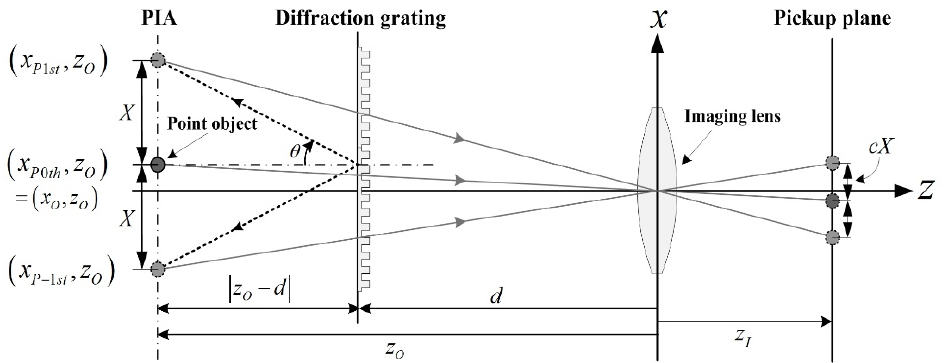
Figure 1. Geometrical relationship between a point object, parallax image array (PIA), and its spatial period X in a diffraction grating imaging.